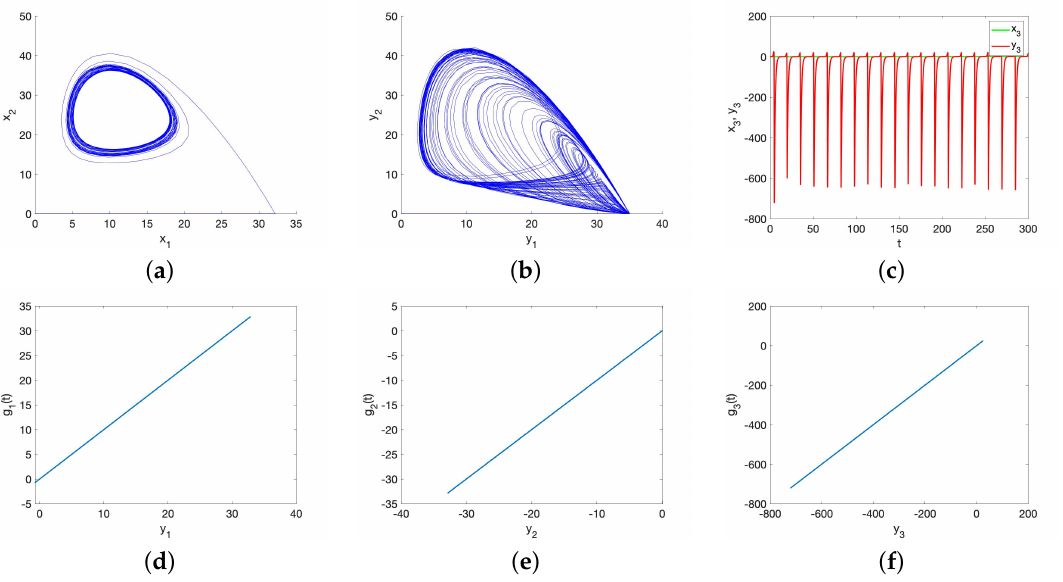
Figure 7. GS for modified UR model and HP model with initial data [ x 1 ( 0 ) , x 2 ( 0 ) , x 3 ( 0 )] = [ 0.0055,0.0014,0.0015 ] and [ y ( 0 ) , y ( 0 ) , y ( 0 )] = [ 0.0026,0.0084,0.0025 ] . ( a ) Phase plot for x 2 3 1 ( b ) Phase plot for y 1 and y 2 . ( c ) Time series plot for x 3 and y 3 . ( d ) y 1 − g 1 plot showing 1:1 correlation. ( e ) y 2 − g 2 plot showing 1:1 correlation. ( f ) y 3 − g 3 plot showing 1:1 correlation.